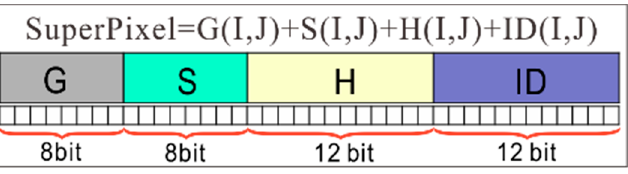
Figure 4. Superpixel occupies a total of 40 bits in the computer, where I , J represent the row and column, G ( I , J ) denotes gray, S ( I , J ) denotes corner coordinate subdivision grid identification value, H ( I , J ) denotes elevation, and ID ( I , J ) represents the identification of a building.